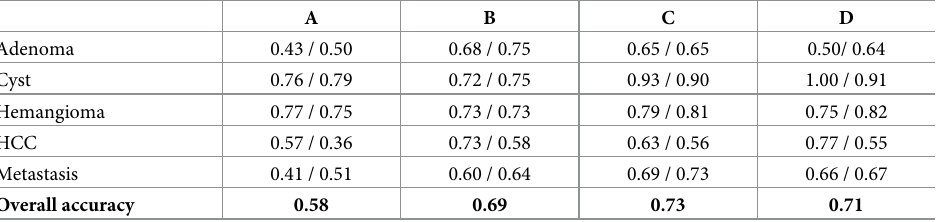
Table 2. Classification results for the four different feature sets (sensitivity/specificity), with 19 features selected.